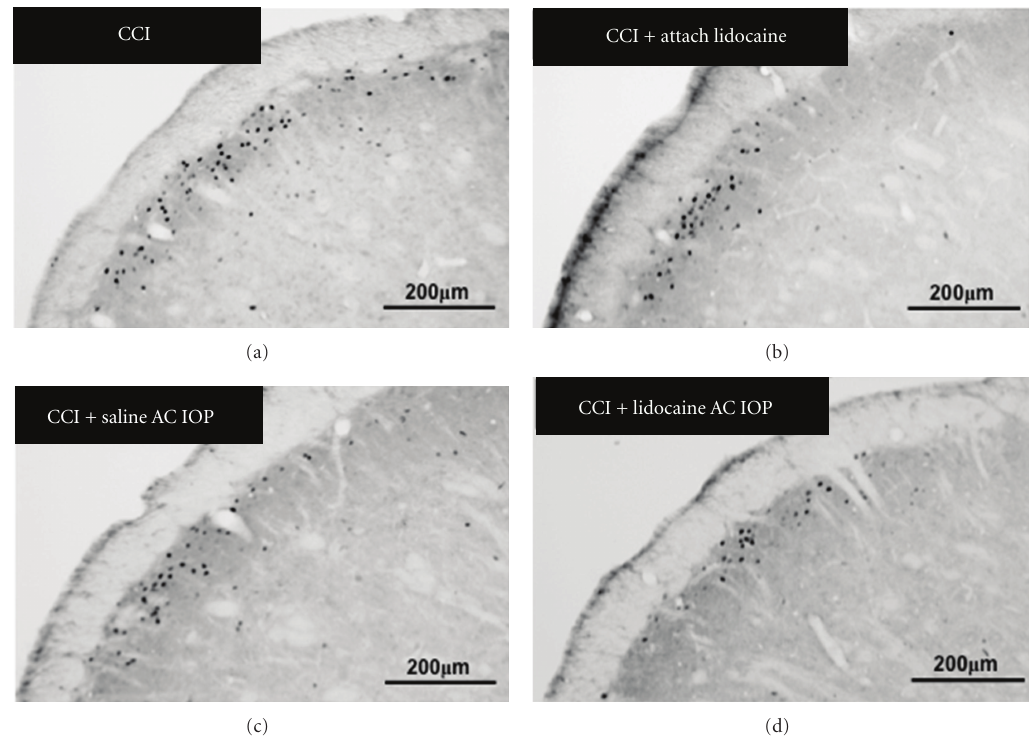
Figure 4: Expression of Fos-LI cells in the trigeminal subnucleus caudalis. A small number of Fos-LI cells was observed in the CCI + lidocaine AC IOP